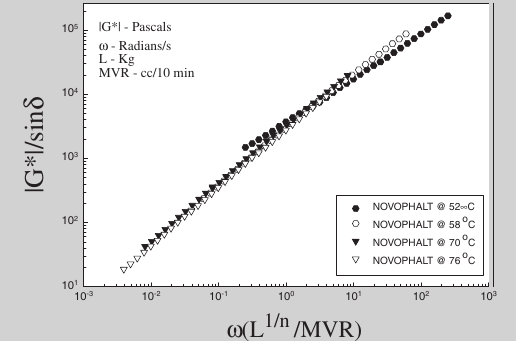
Figure 4 (left): Unified curve of the SHRP parameter |G*|/sin d with modified fre- quency w (L1/n/MVR) cover- ing temperature range of 52˚C - 76˚C for Novophalt original unaged sample. Figure 5 (left): Unified curve of the SHRP parameter |G*|/sin d with modified fre- quency w (L1/n/MVR) cover- ing temperature range of 58˚C - 76˚C for Styrelf origi- nal unaged